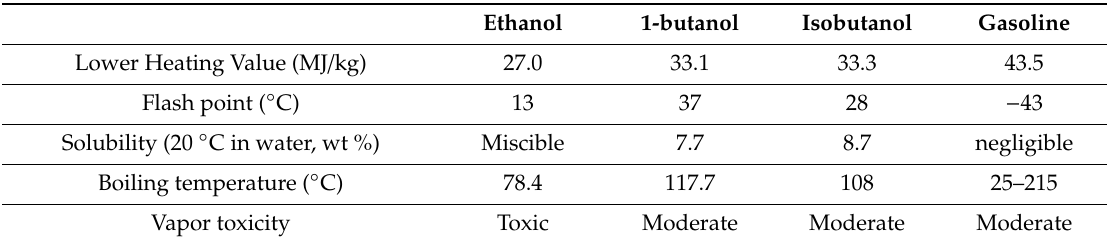
Table 1. Major characteristics comparison of several common biofuels with